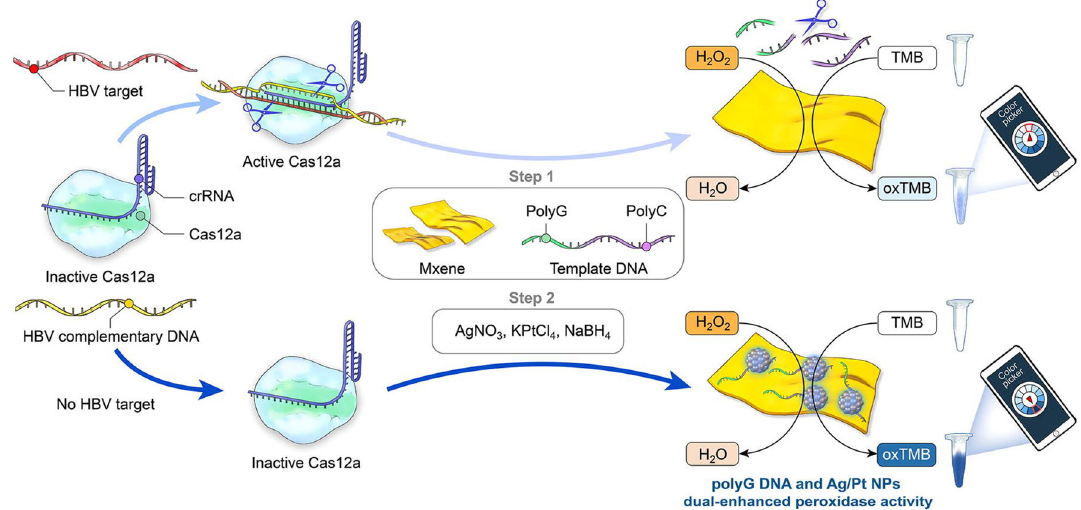
Fig. 5 The principles of CRISPR-Cas12a based colorimetric biosensor designed for specific detection of hepatitis B virus (HBV) DNA using MXene-probe DNA-Ag/Pt nanohybrids with catalytic performance. TMB: 3,3 ʹ ,5,5 ʹ -Tetramethylbenzidine. Reproduced with permission